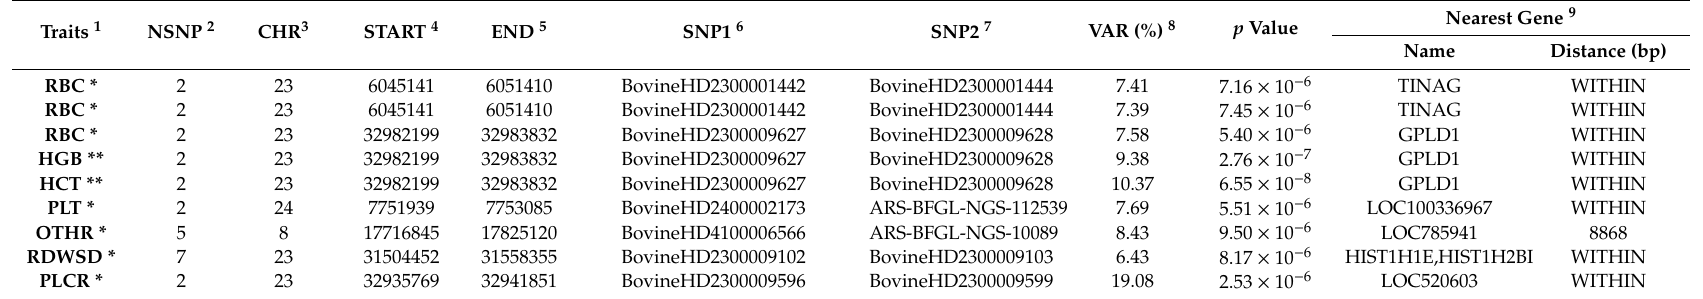
Table 3. Associated haplotype blocks and nearby candidate genes for hematological